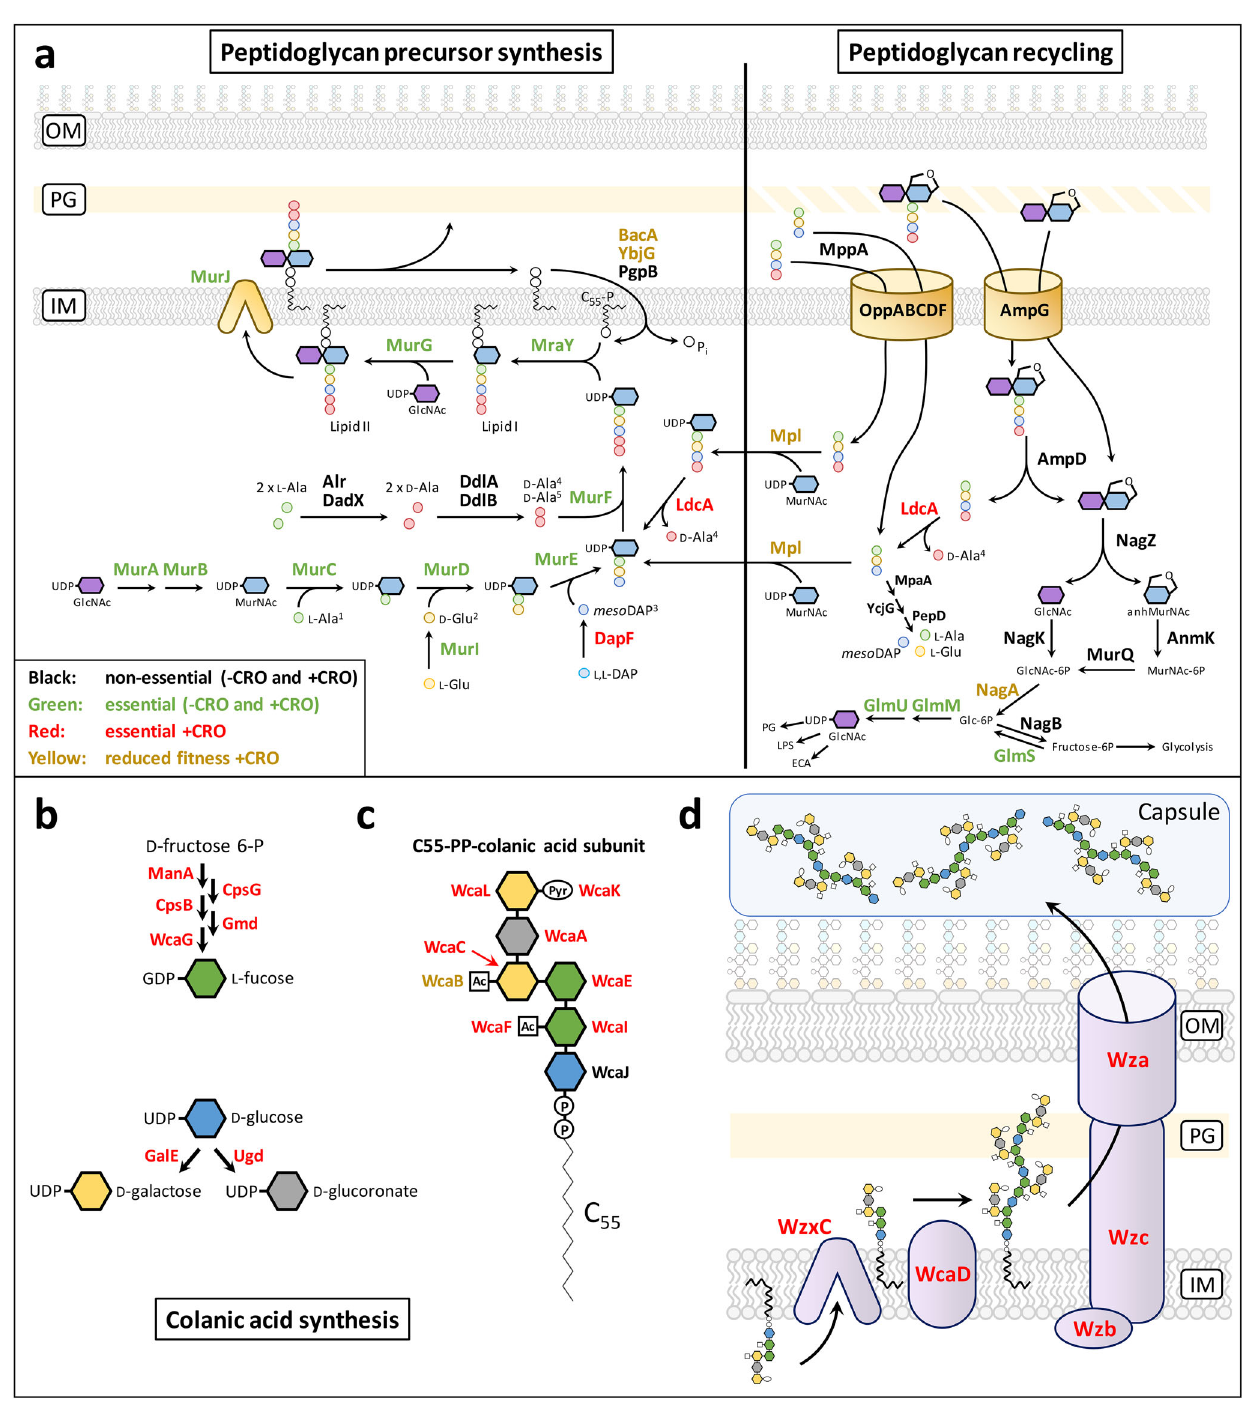
Fig. 4 | Essentiality of genes involved in PG recycling and colanic acid bio- synthesis. a The PG subunit is assembled both by de novo synthesis (left) and recycling of PG fragments (right). b Synthesis of colanic acid nucleotide sugar precursors. c Assemblyof thecolanicacid subunitlinked tothe undecaprenyllipid